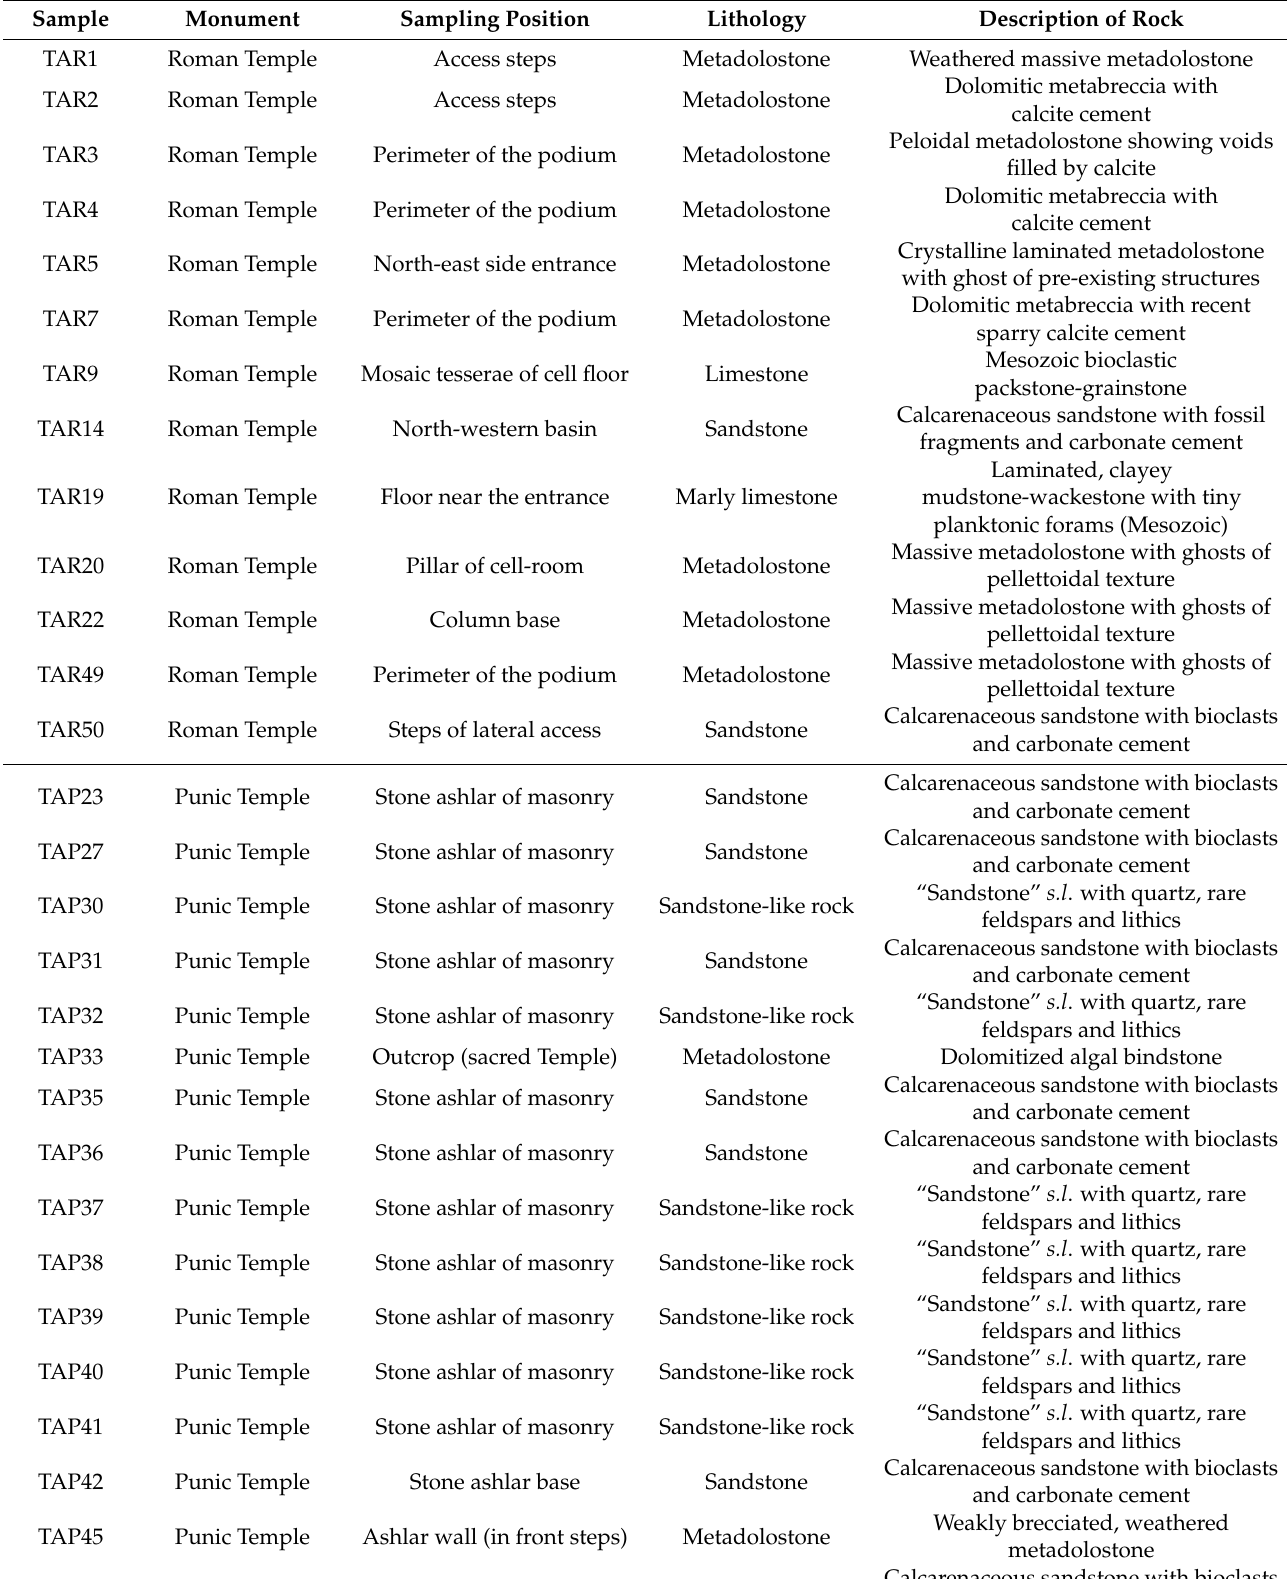
Table 1. Sample list summarizes the sampling position of stones and lithology description. “Sandstone” s.l. = “Sandstone” sensu lato